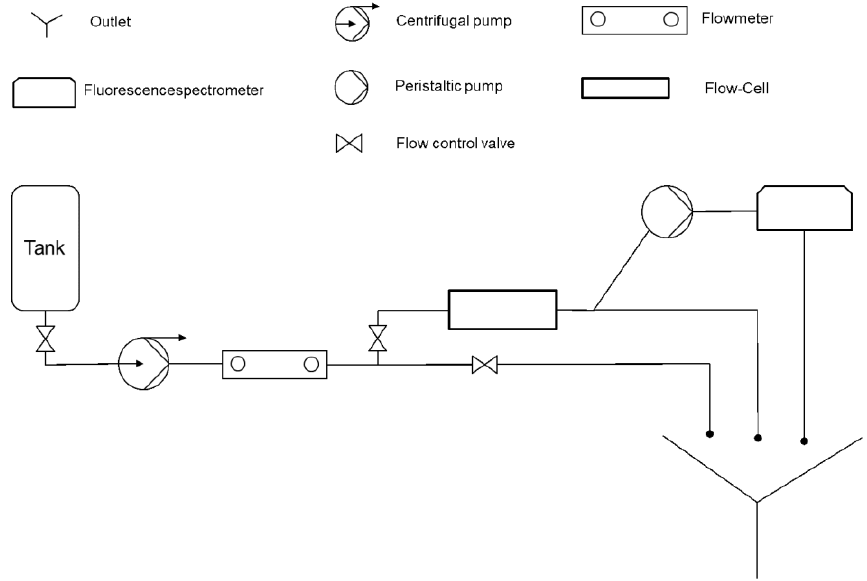
Figure 7. Experimental setup for cleaning tests.